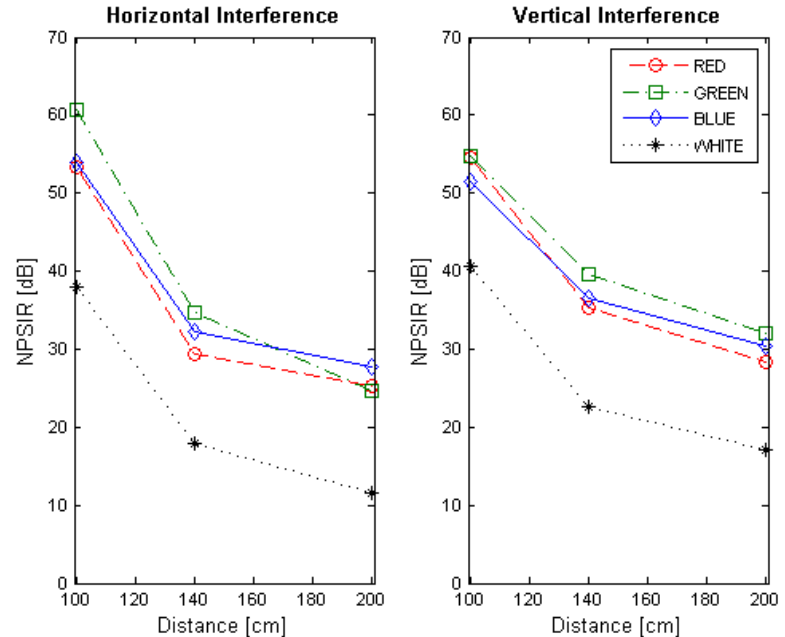
Figure 16. Normalized Power Signal to Interference Ratio for transmitting in white. The left chart presents the interference of close emitters located on the same horizontal line. Right chart shows the interference of the transmitters within the same vertical